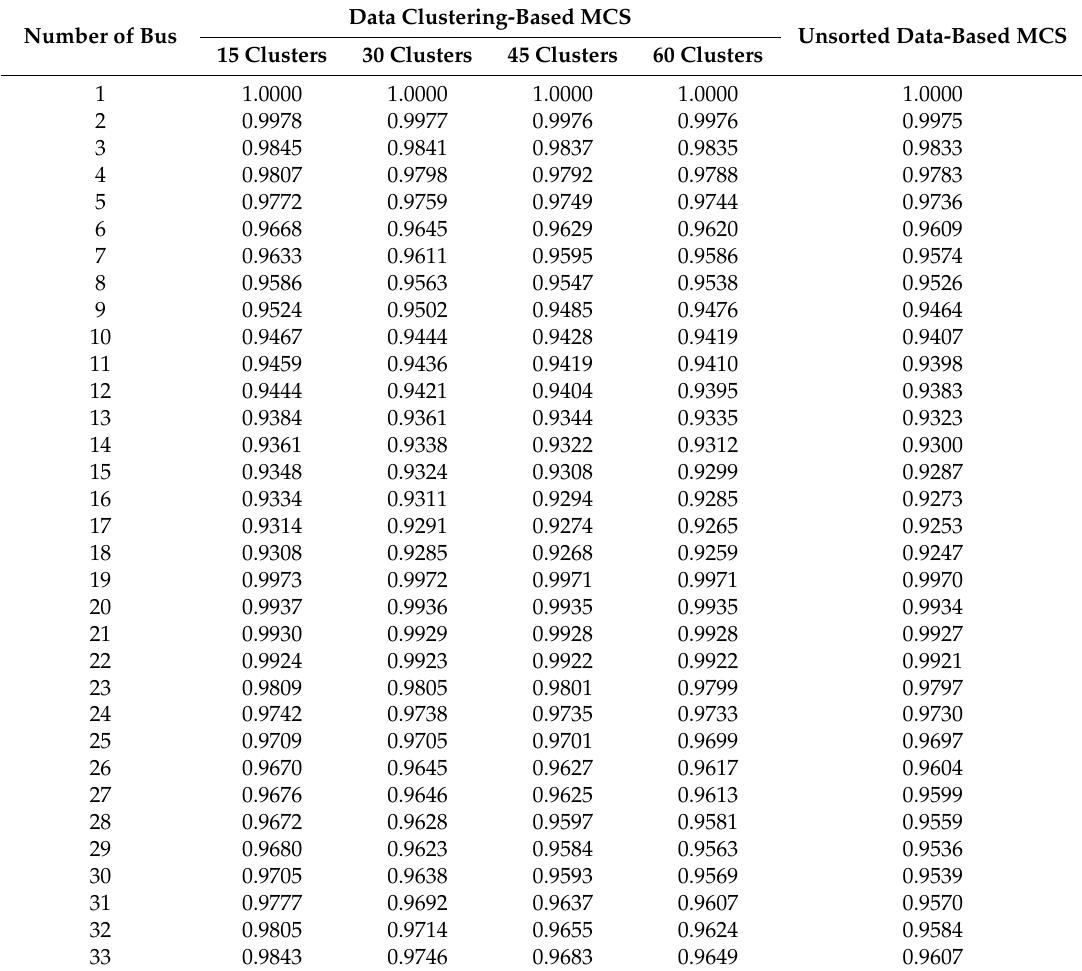
Table 4. Voltage magnitudes with the proposed data clustering-based direct PLF (33-bus